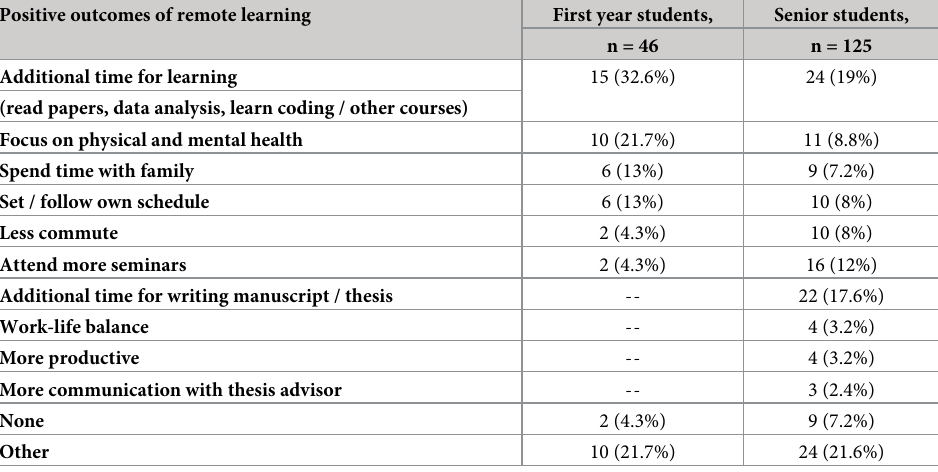
Table 2. Positive outcomes experienced by students as a result of remote